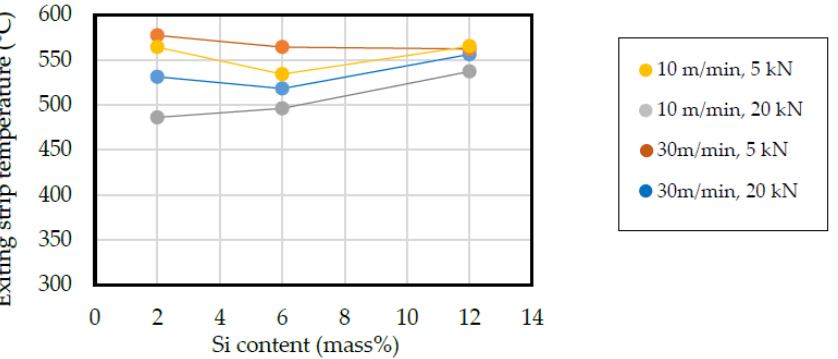
Figure 9. Effects of roll speed, roll load, and Si content on Al-Si strip temperature after exiting the rolls. The strip temperature increased and decreased after exiting the rolls. This figure shows the highest temperatures. Roll speed: 10 m/min and 30 m/min; roll load: 5 kN and 20 kN; Si content: 2%, 6%, and 12%.